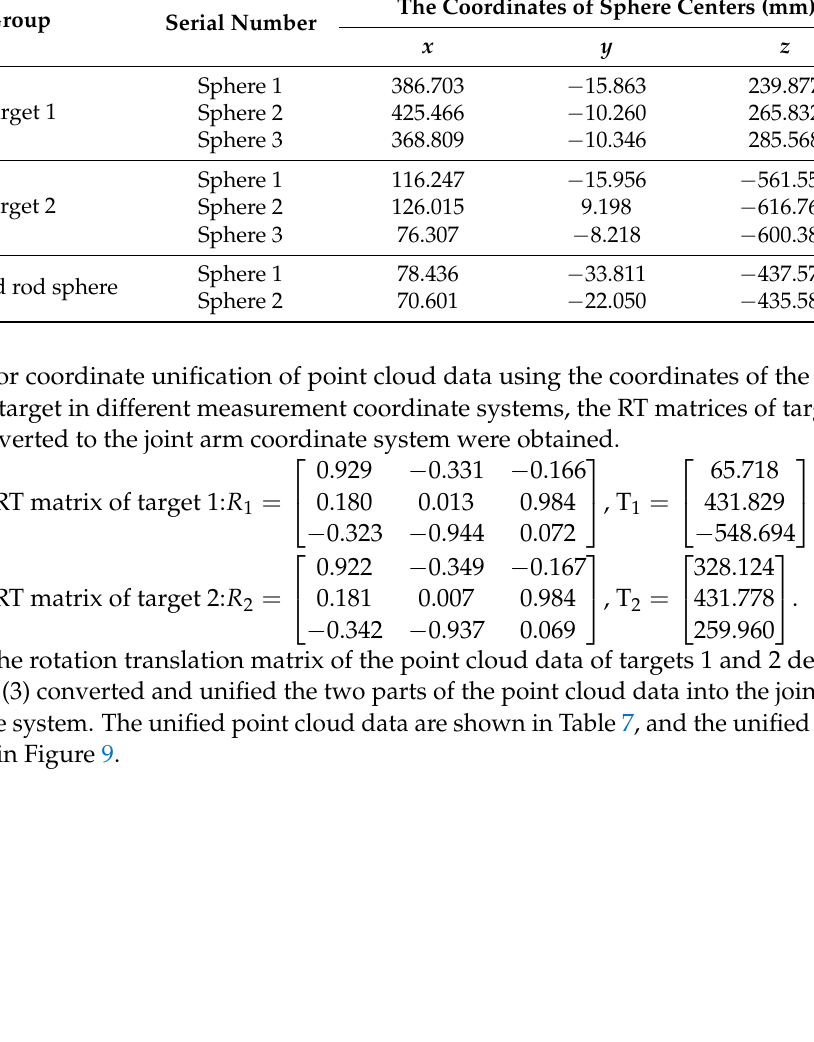
Table 6. Sphere center values of the scanner’s detection target.